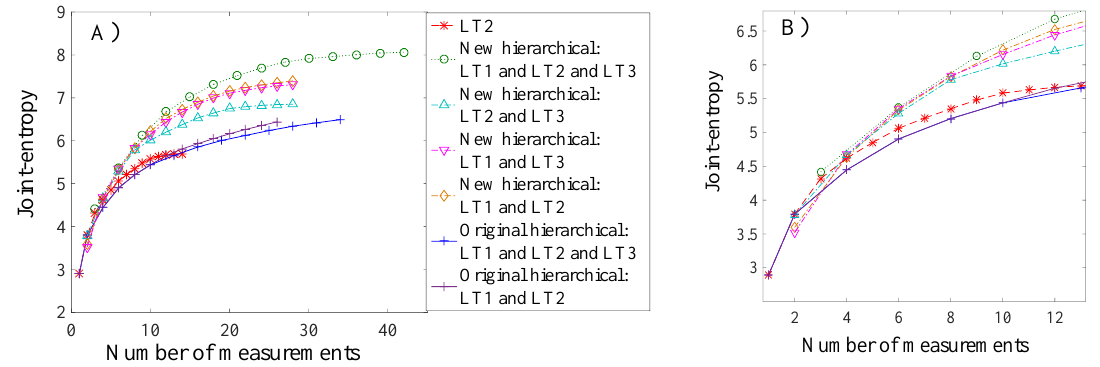
Figure 15. Joint entropy as a function of the number of measurements for various sensor placement methodologies involving various number of load tests ( A ). ( B ) Zoom-in of the figure on the left.